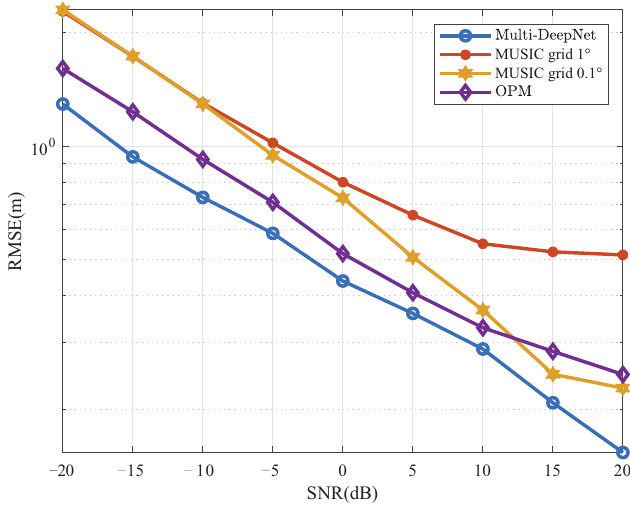
Figure 11. RMSE of location estimation with SNR.